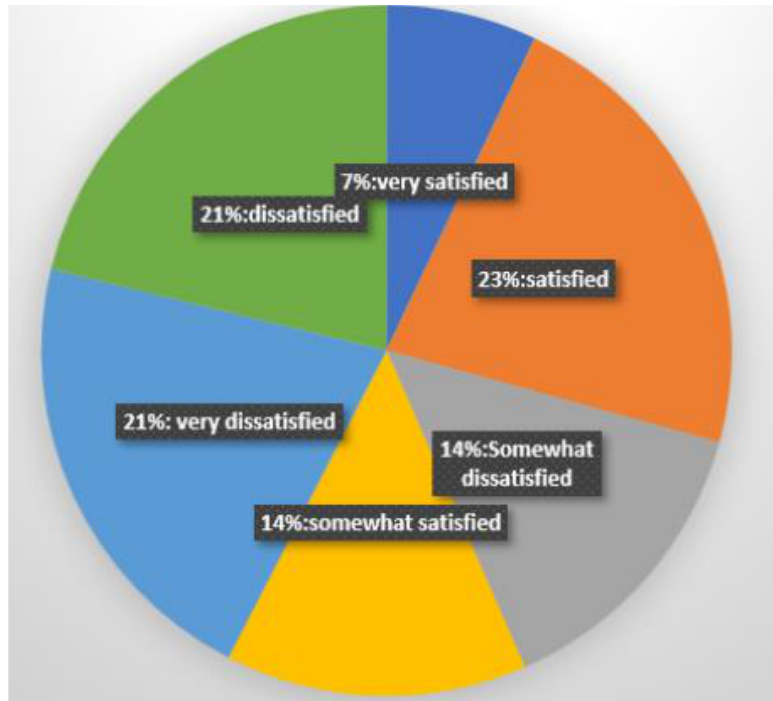
Figure 3. Water user satisfaction on JIRAMA services (Data source: STILEEX) .